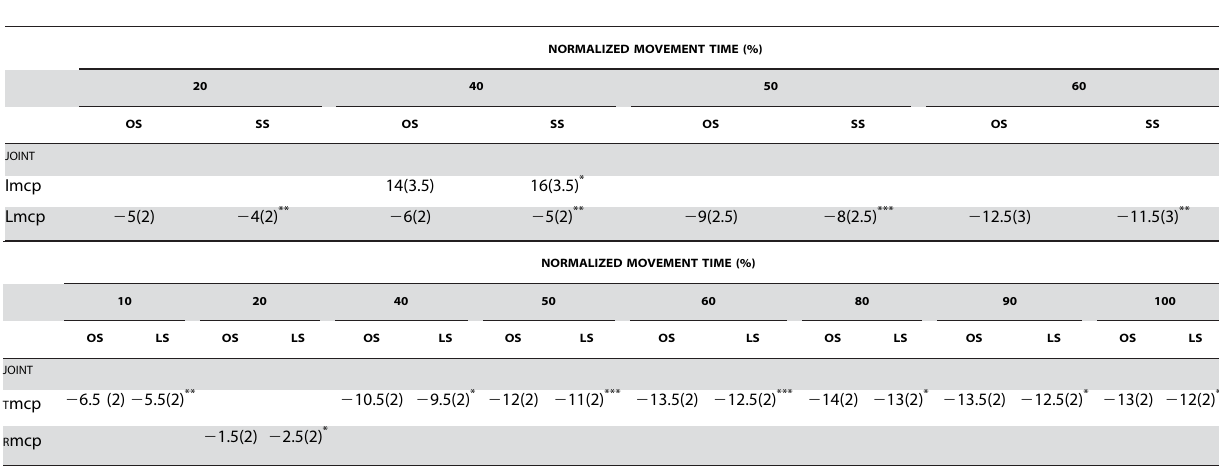
Mean standard errors are reported in parentheses. The relevant statistical comparisons are between the ‘OS’ and the ‘SS’ conditions and the ‘OS’ and the ‘LS’ conditions. Notes. Only significant results are reported (*= p , .05; **= p , .01, ***= p , .001). OS=Odourless air - Small target; SS=‘Small’ odour - Small target; LS=‘Large’ odour - Large target. Tmcp=metacarpal joint of the thumb; Imcp=metacarpal joint of the index finger; Rmcp=metacarpal joint of the ring finger; Lmcp=metacarpal joint of the little finger.